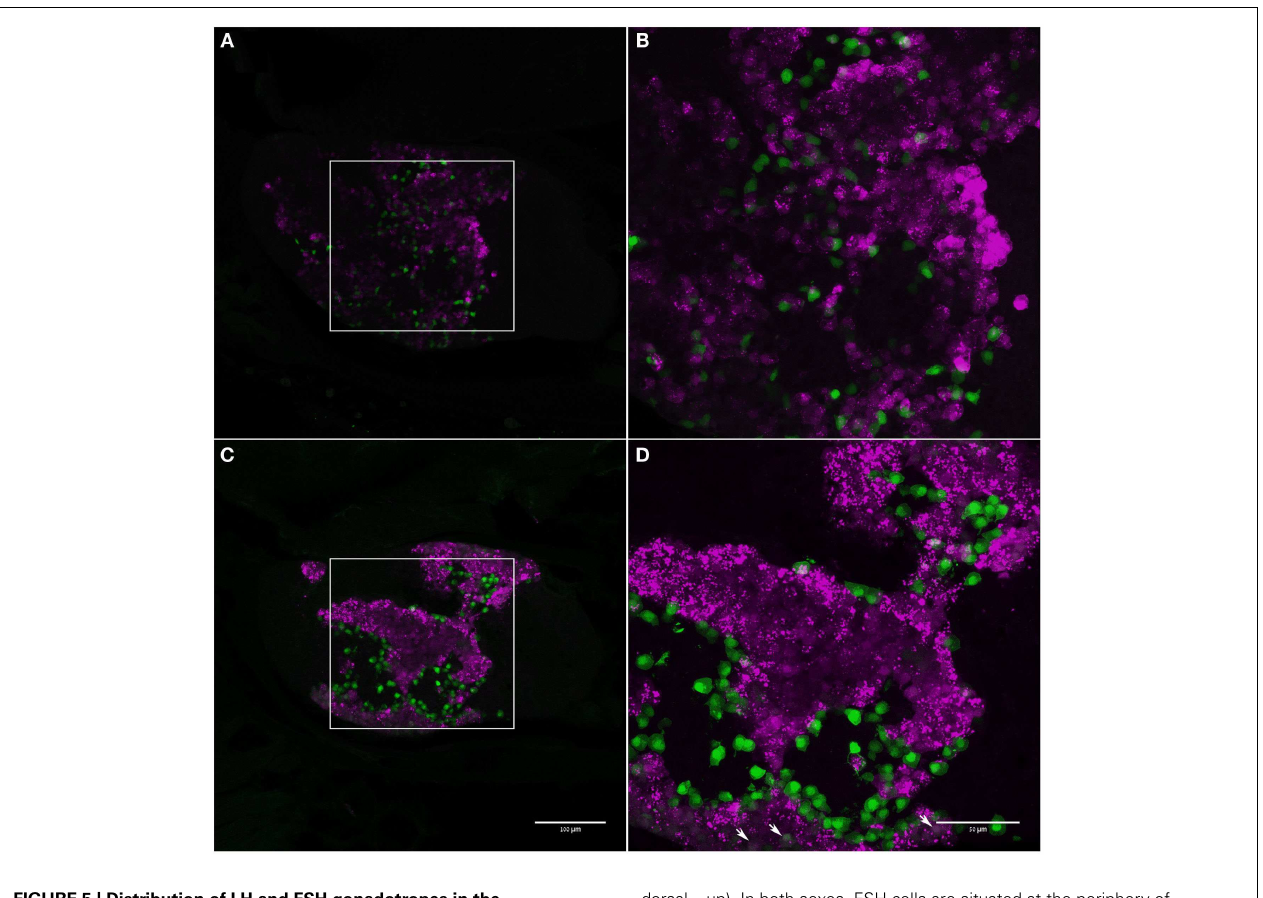
FIGURE 5 | Distribution of LH and FSH gonadotropes in the pituitary of adult zebrafish . Adult male (A,B) and female (C,D) double-transgenic zebrafish expressing EGFP (green) in FSH gonadotropes and mCherry (magenta) in LH cells. Boxed areas in (A) and (C) mark the areas imaged in (B,D) , respectively (anterior – left;